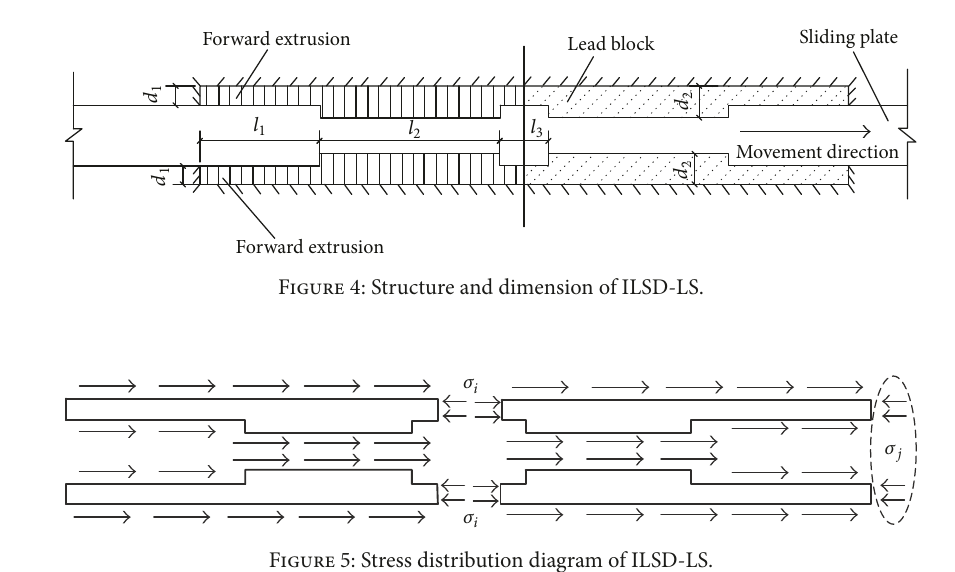
Figure 5: Stress distribution diagram of